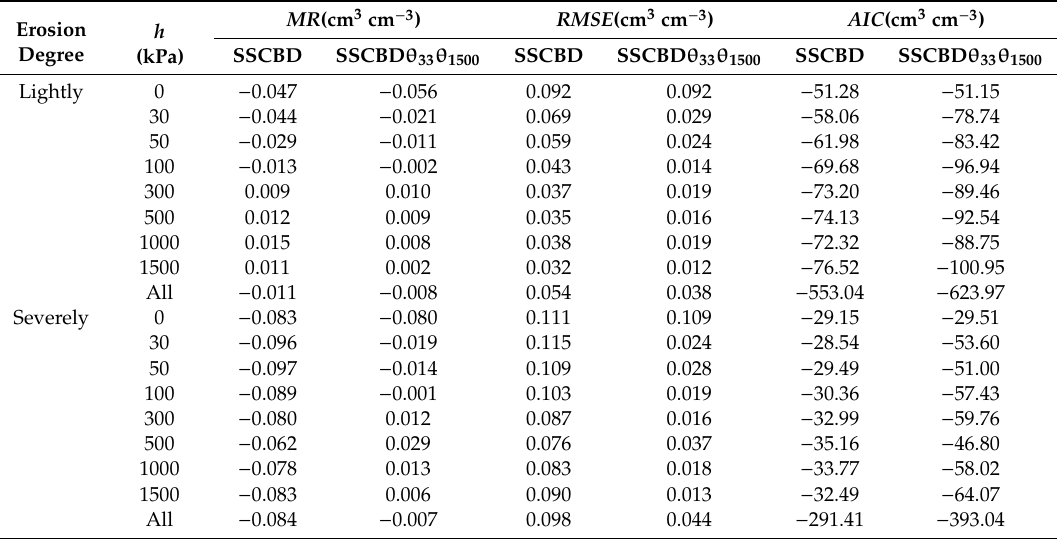
Table 7. MR , RMSE and AIC between simulated and measured soil water contents for the lightly and the severely eroded soils after the correction.